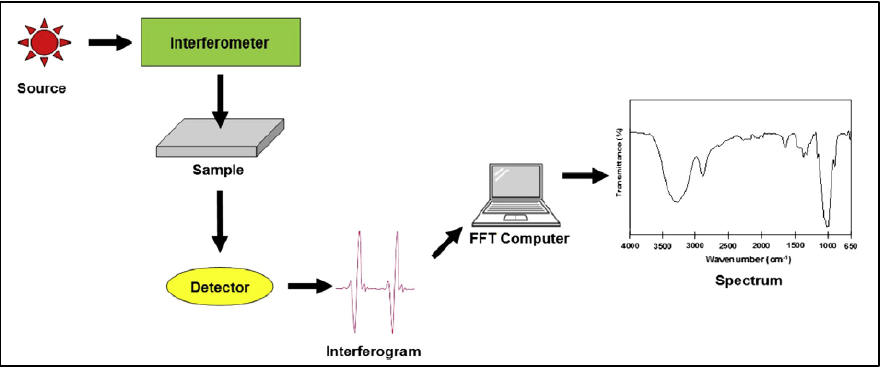
Figure 20. Components of FTIR spectroscopy for detection of functional groups [32].